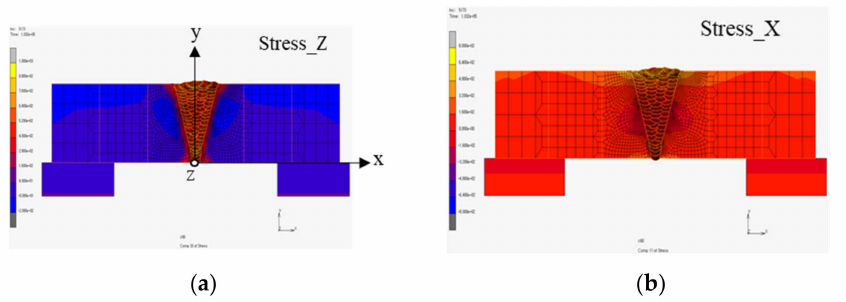
Figure 12. Welding residual stress at the restraint of 300 MPa/mm, a thickness of 70 mm, and a yield stress of 330 MPa: ( a ) welding direction stress and ( b ) width direction